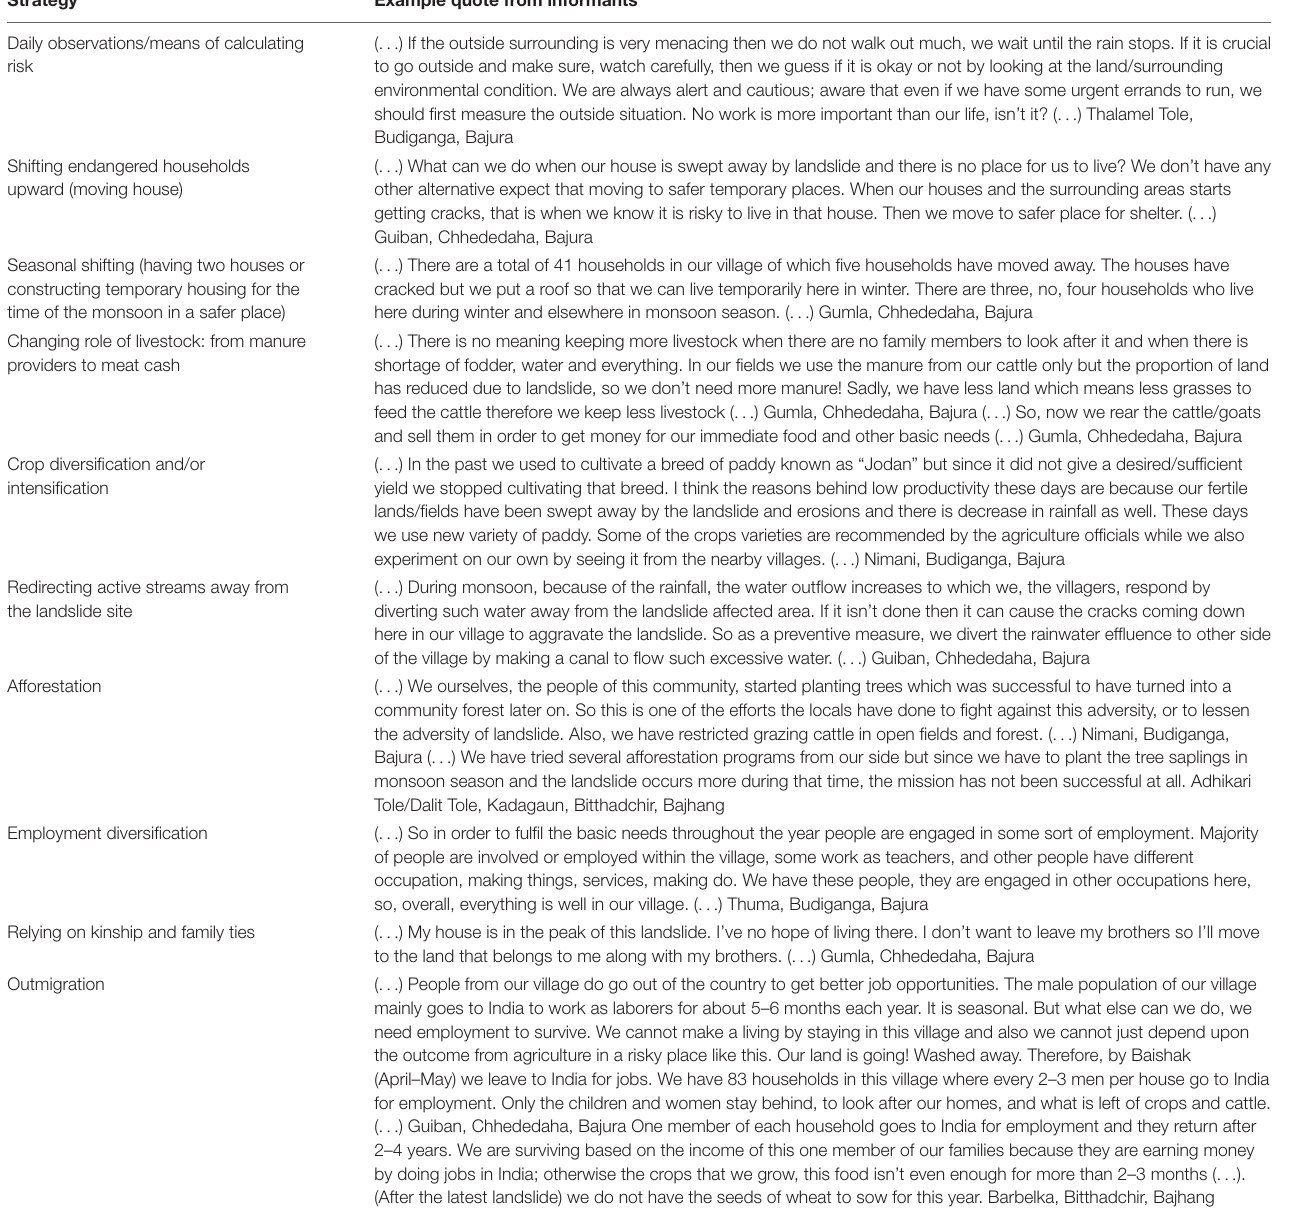
TABLE 3 | Existing local strategies, example quotes by various informants. Strategy Example quote from